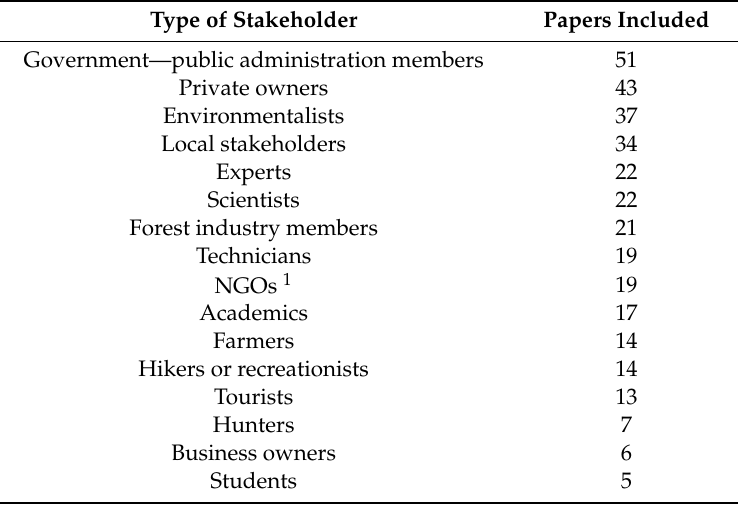
Table 7. Type of stakeholders selected.